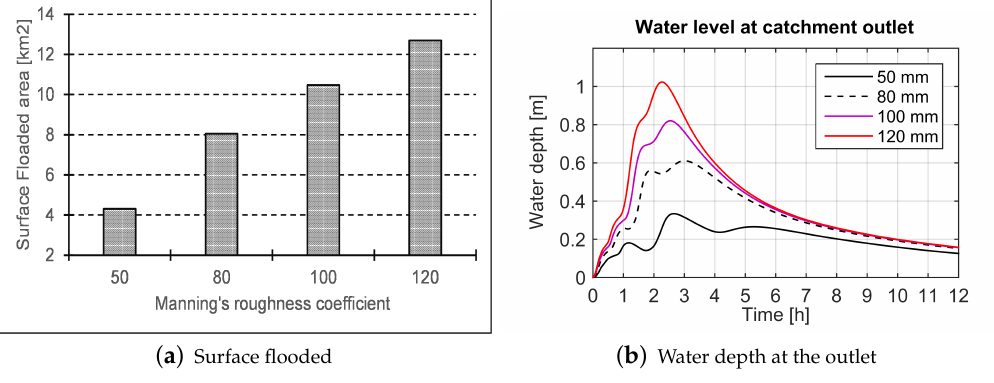
Figure 4. Flood maps for different values of rainfall intensity when the watershed is considered as bare soil.